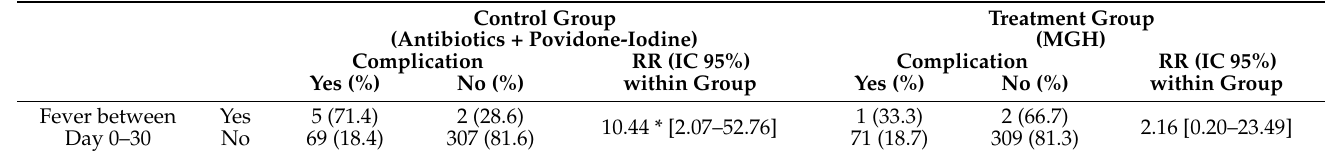
Table 4. Overview of patients who developed a fever within 30 days after the CS procedure, presented per study group. Both the control and treatment groups consisted of 383 patients, with 74 and 72 patients considered to have postoperative complications, respectively. Subgroups were based on the presence or absence of postoperative complications. * represents a significant difference ( p < 0.05). Treatment Group Control Group (MGH) (Antibiotics + Povidone-Iodine) Complication RR (IC 95%) within Group